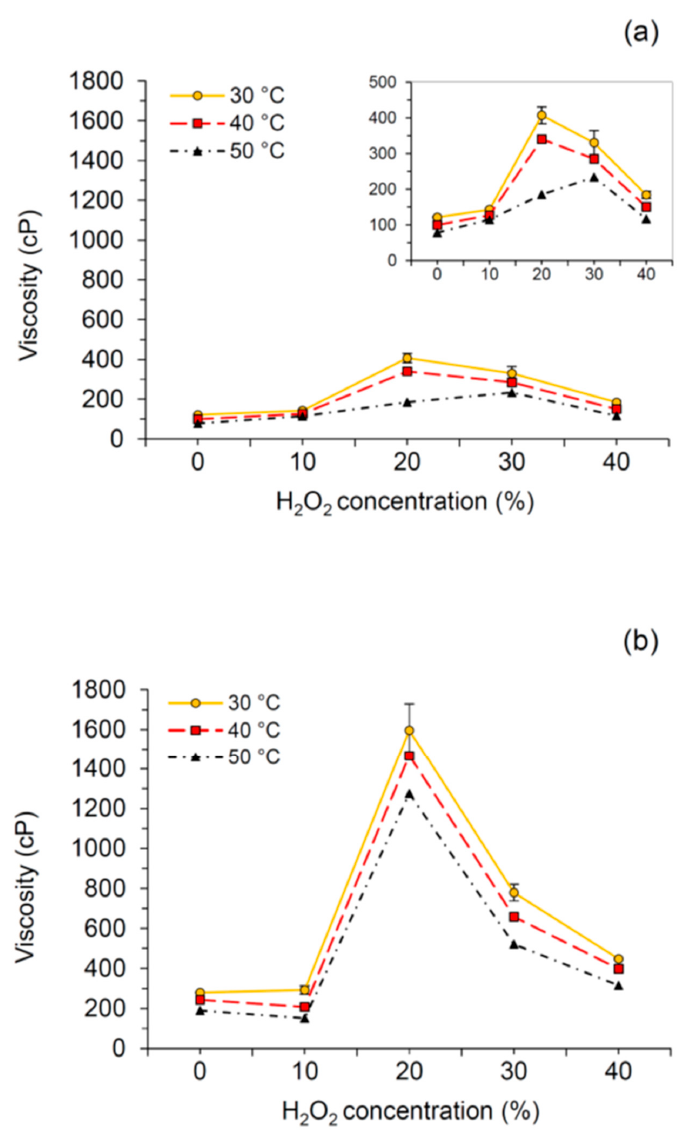
Figure 3. Viscosity of ( a ) CMCp and ( b ) CMCb at different temperature. Abbreviations: CMCp, CMC from palm bunch; CMCb, CMC from bagasse.